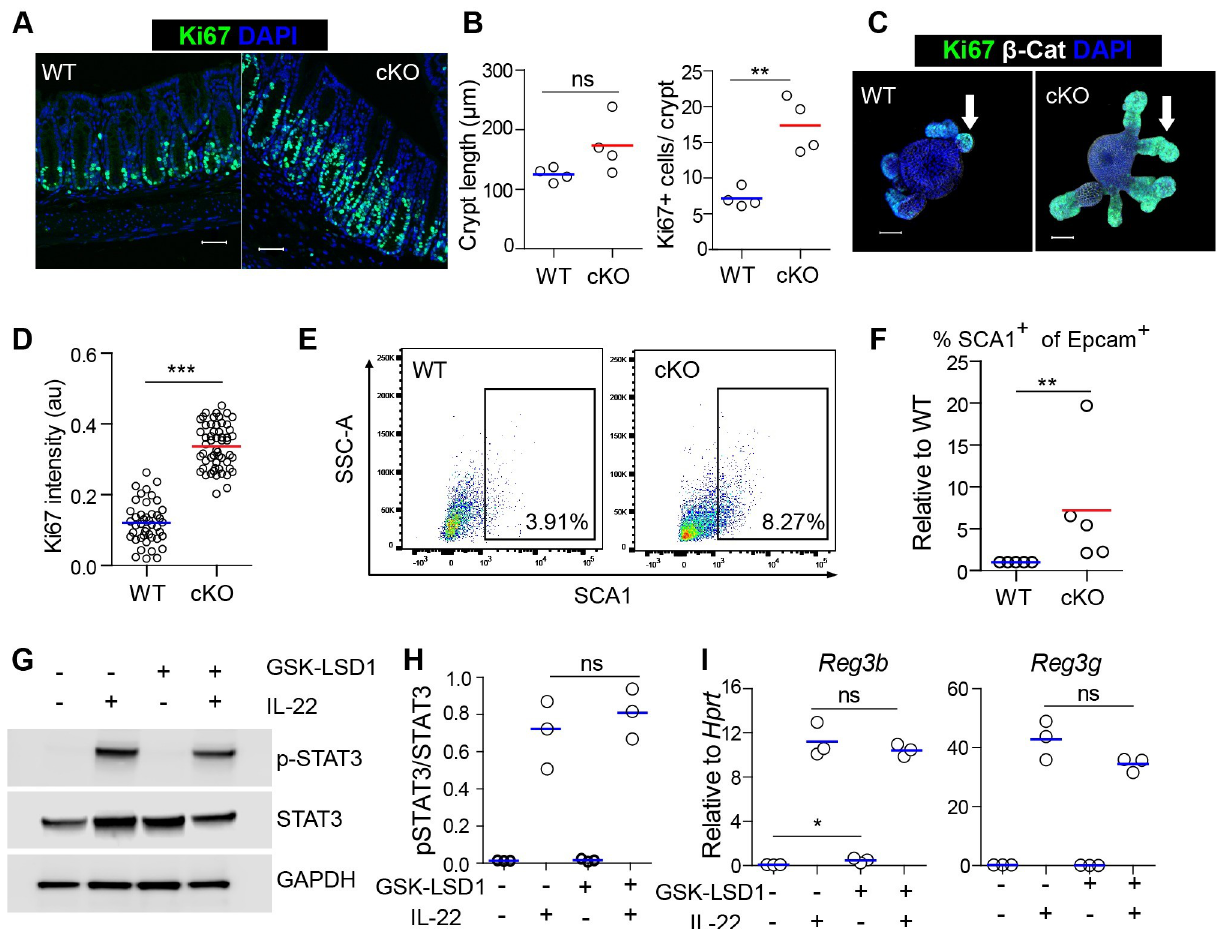
Fig 1. Intestinal epithelial Lsd1 deletion induces proliferation and a repair-like state in epithelium of mice. (A) Immunofluorescent images of Ki67 + (green) in colonic epithelium of WT and cKO adult mice. DAPI was used as a nuclear counterstain. (B) Quantification of crypt length in na ï ve WT and cKO adult mice. Quantification of Ki67 + cells in colonic crypts of WT and cKO adult mice. n = 4 mice in each group, line is mean. (C) Organoids from WT and cKO mice were cultured for 3 days. The expression of Ki67+ (green) was determined by immunofluorescence. (D) Quantification of Ki67 intensity per organoid area in budding organoids from WT and cKO mice. Each dot represents 1 organoid. (E) Crypts cells were isolated from colon of WT and cKO adult mice and flow cytometric analysis of SCA1 was carried out. (F) Quantification of SCA1 + positive cells in crypts from WT and cKO adult mice, lines indicate littermate controls. n = 5 mice (G) Organoids were treated with GSK-LSD1 for 4 days followed by IL-22 stimulation for 30 minutes. Whole cell lysates were prepared and subjected to immunoblot analysis of p-STAT3, STAT3, and GAPDH. (H) Band intensity of pSTAT3 and STAT3 was measured using Image Studio Lite by LICOR. Each dot represents one biological replicate. (I) Organoids were co-cultured with GSK-LSD1 (5 μ M) and IL-22 (10 ng/ml) for 4 days in ENR (EGF, NOGGIN, R-SPONDIN) medium. The mRNA expression of Reg3b and Reg3g was determined by RT-qPCR relative to housekeeping gene Hprt . n = 3 biological replicates of a representative experiment. Unpaired two-tailed Student’s t test (B, D,H & I) was performed to observe significant differences. ns = not significant, � P � 0.05, �� P < 0.01, ��� P �